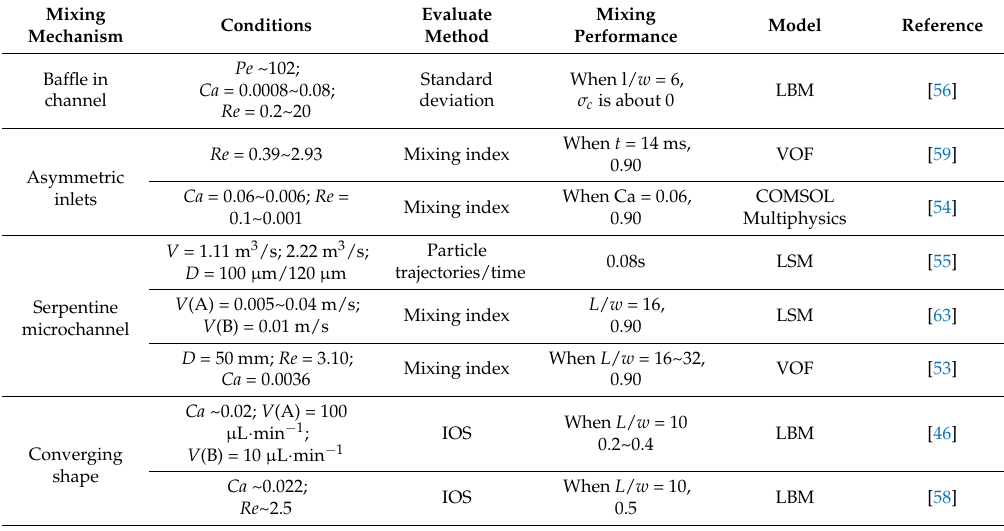
Table 3. Some studies on simulation of mixing performance in recent